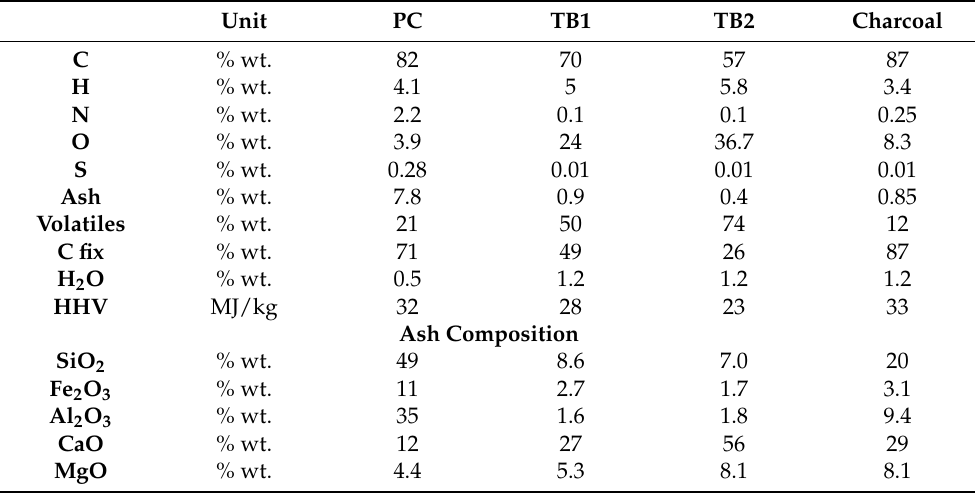
Table 1. Analysis of used reductants for injection and top charging, VM = volatile matter, HHV = higher heating